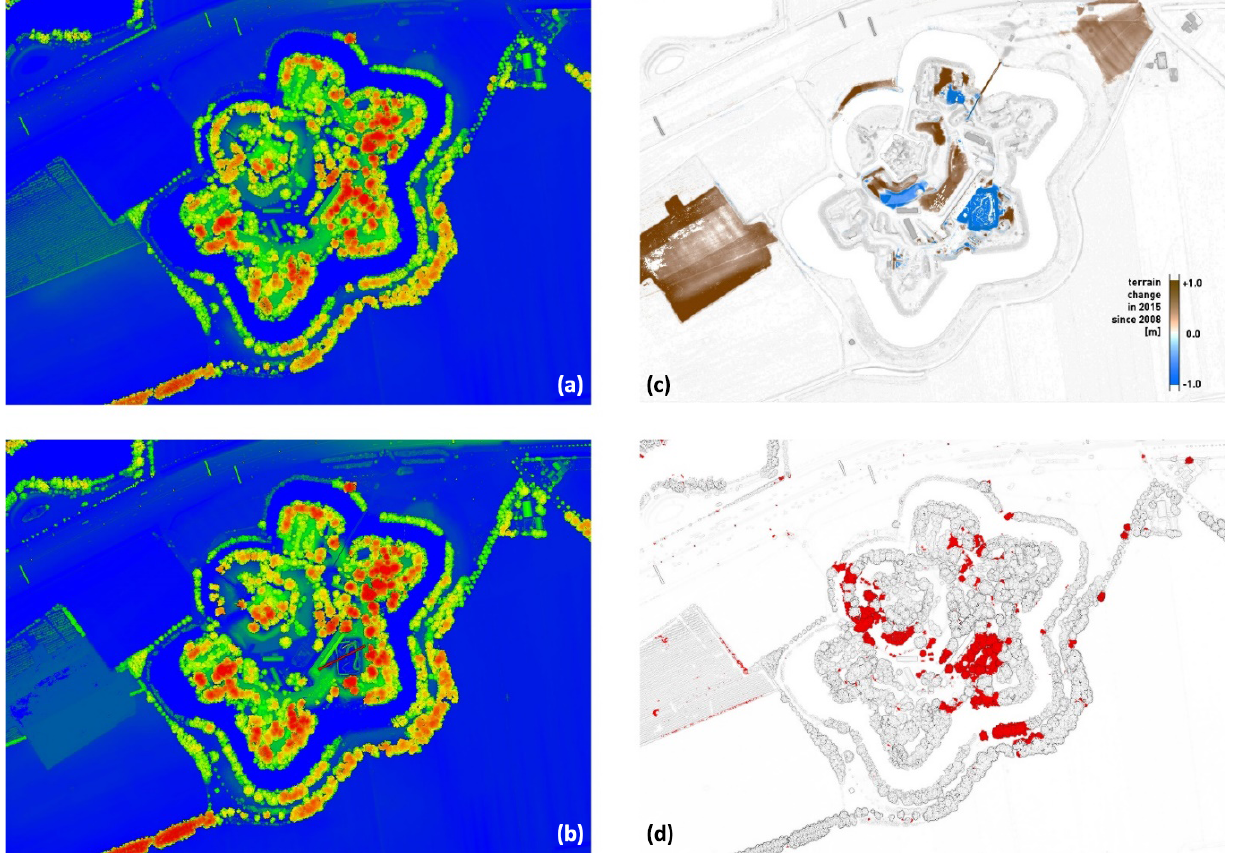
Figure 2. Change detection between point cloud models shows a landscape design implemented at Fort Vechten, in the Netherlands. The two models, shown in plan view, were produced from the aerial laser scanning data collected by the Dutch government in 2008 (a) and 2015 (b) and are colored by height (0–30 m AMSL). A geometric change detection, per- formed on ground points only, highlights the terrain volume that has been added or subtracted by 1 m height or more on the 2015 point cloud model (c). The distance calculation of 2 m or more highlights the trees removed since the 2008 record